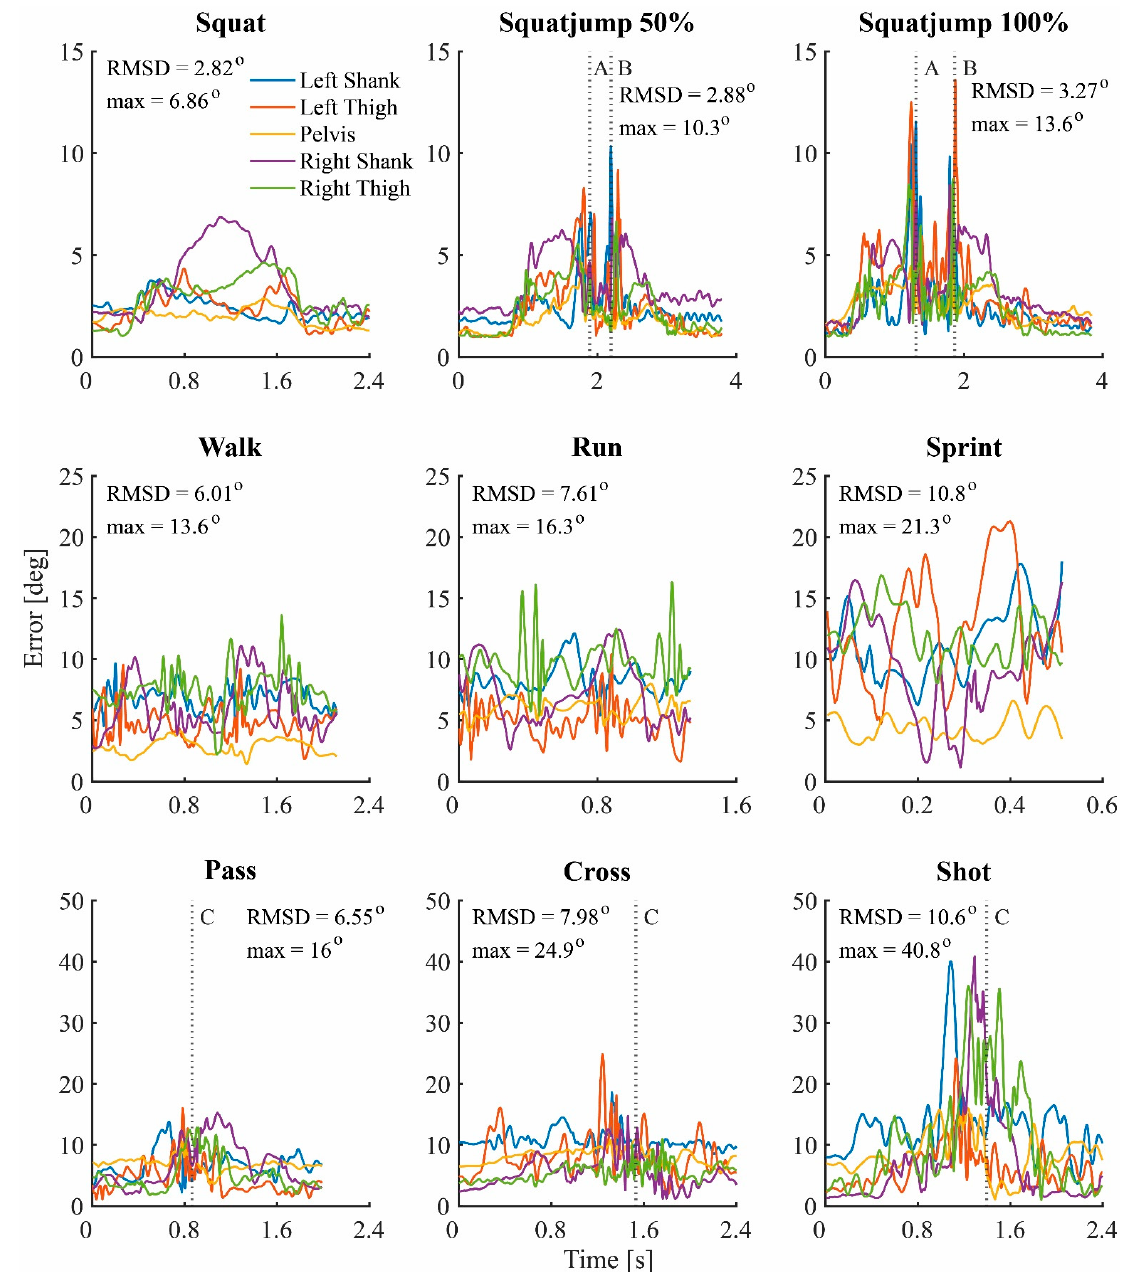
Figure 6. Error of the orientation filter, plotted for each trial over time of a typical subject. The exact same trails were used as in Figure 5. In the top right corner of each plot the root-mean-square difference (RMSD) across all body segments and maximum error are displayed in degrees. The vertical dashed line represents a specific moment in time: A = push off, B = landing, C = ball contact.